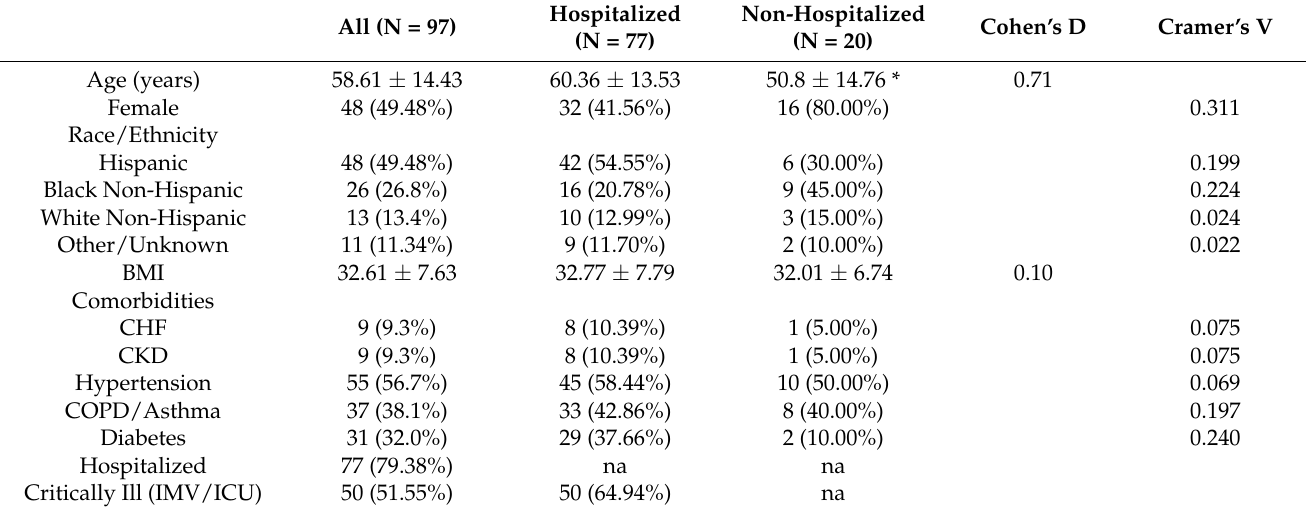
Table 1. Demographics of CORE patients. Mean ± SD or (%), N = 97. * p < 0.05 between hospitalized and non-hospitalized